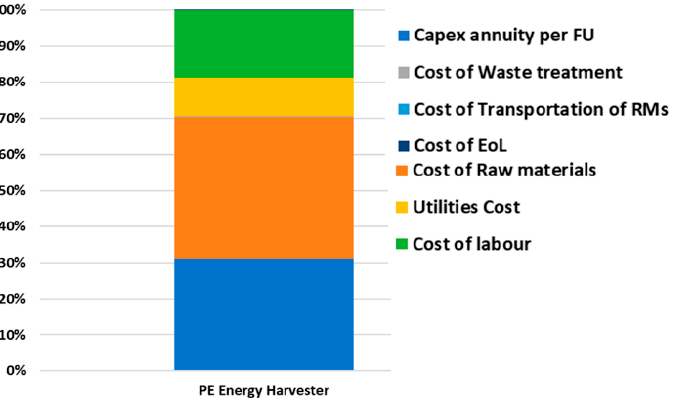
Figure 2. Cost breakdown of a PE module .